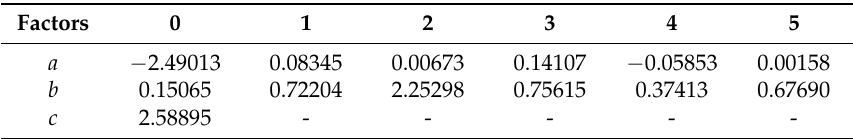
Case 3 : AOD and water vapor data are not available (see Table 5 the values for factors a , b and c ):